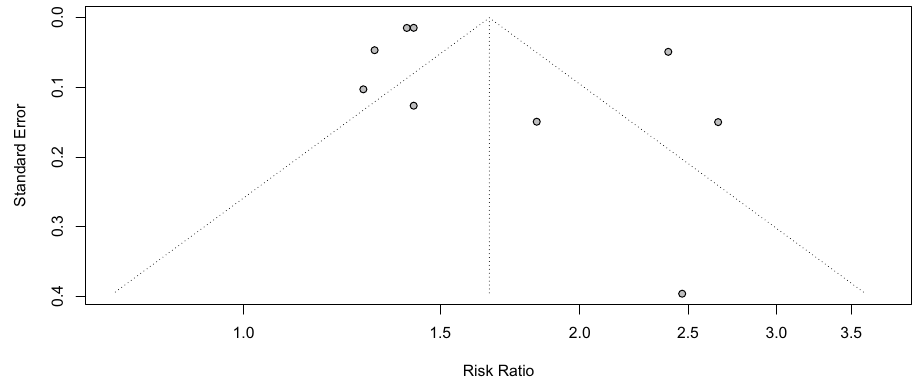
Figure 4. Funnel plots to assess potential for small-study publication bias 26 . Symmetrical inverted funnel plot suggested absence of publication bias.